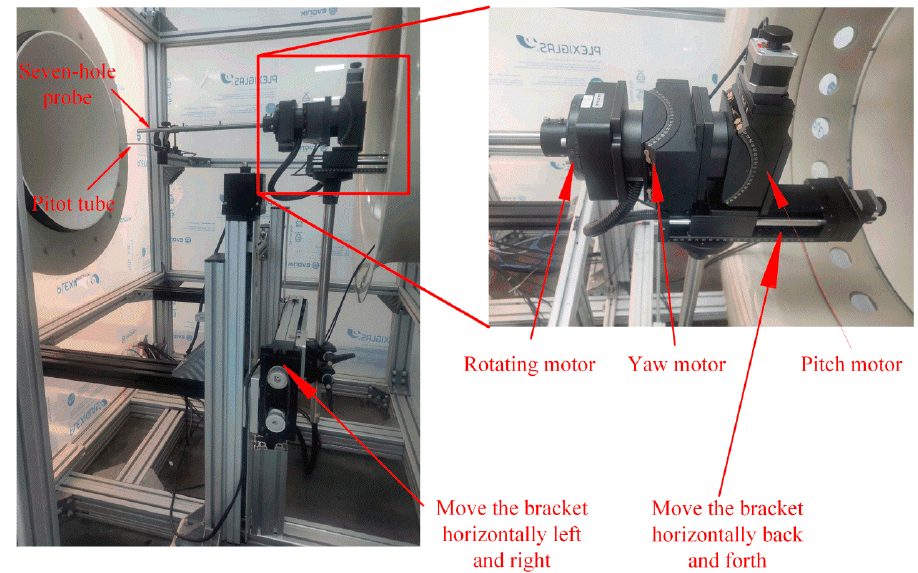
Figure 4. Three-coordinate mobile bracket.